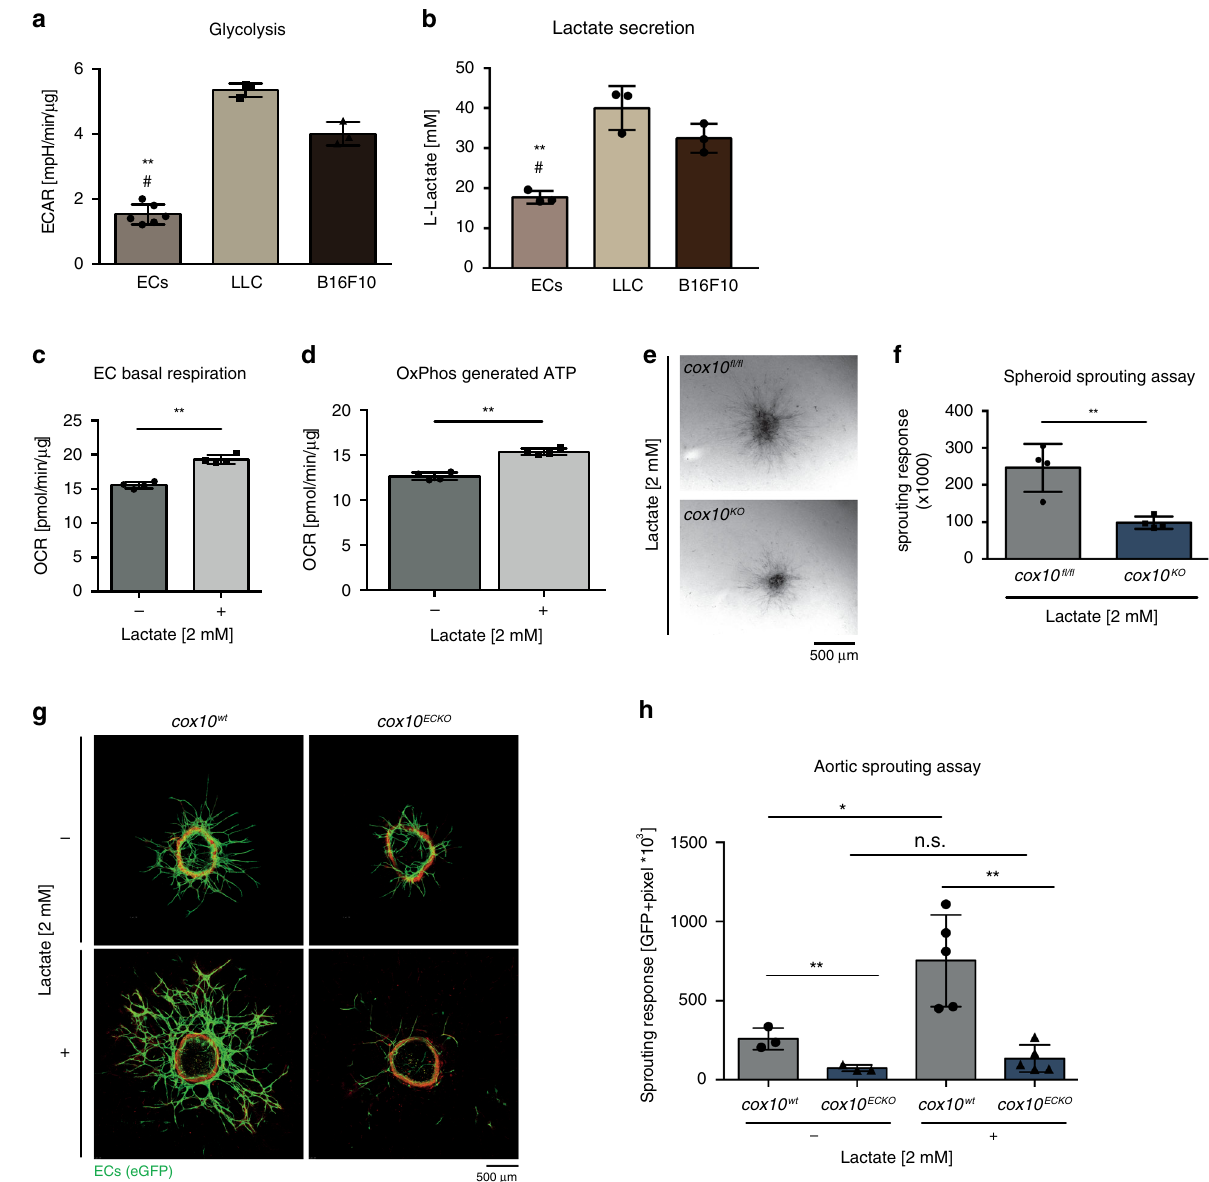
Fig. 5 Lactate fuels EC respiration. a Calculated glycolysis rate of murine lung ECs, murine Lewis Lung Cell Carcinoma (LLC) cells and murine B16F10 melanoma cells. b Analysis of L-lactate medium levels secreted by ECs and murine tumour cell lines B16F10 and LLC. c Basal respiration of isolated murine ECs with or without lactate supplementation. d Calculated OxPhos coupled ATP levels of primary murine lung ECs in the absence or presence of lactate. e Representative bright fi eld images of sprouting spheroids exposed to lactate. f Quanti fi cation of sprouting response. g Representative aortic ring explants in the presence and absence of lactate. h Quanti fi cation of the sprouting response. Data are presented as mean ± SD. Individual data points in ( a ), ( b ), ( c ), ( d ) and ( f ) represent technical replicates within a representative experiment. Individual data points in ( h ) represent mean values of individual mice of the respective genotype. Sample sizes: a LLC, B16: n = 3, ECs n = 6, b n = 3 for all cells, c n = 4 vs. 4, d n = 4 for both conditions, f n = 4 vs. 4, h n = 3 vs. 3 ( − lactate); n = 5 vs. 5 ( + lactate). Exact p -values (unpaired students t -test, two-tailed): c <0.0001, d <0.0001, f 0.0044, h * = 0.0305, ** = 0.0107, n.s.